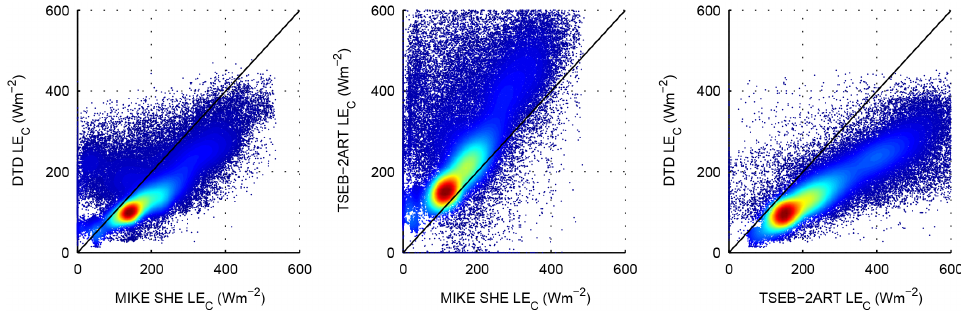
Figure 7. Density scatter plot comparing the vegetation latent heat flux modelled by MIKE SHE and DTD (left), MIKE SHE and TSEB- 2ART (centre) and TSEB-2ART and DTD (right). Red colour indicates higher density of points, blue colour lower density. Table 4. Statistical comparison between MIKE SHE, DTD and TSEB-2ART models for latent heat flux of the canopy (LE C ). Statistics used: correlation coefficient ( r ), root mean square difference (RMSD), systematic and unsystematic root mean product differences (RMPD s and RMPD u respectively), the percentage of mean square difference (MSD) attributed to systematic and unsystematic mean product differ- ences (MPD) (MPD s / MSD and MPD u / MSD respectively) and bias. The statistics are in Wm − 2 , with the exception of MPD s / MSD and MPD u / MSD, which are percentages. r